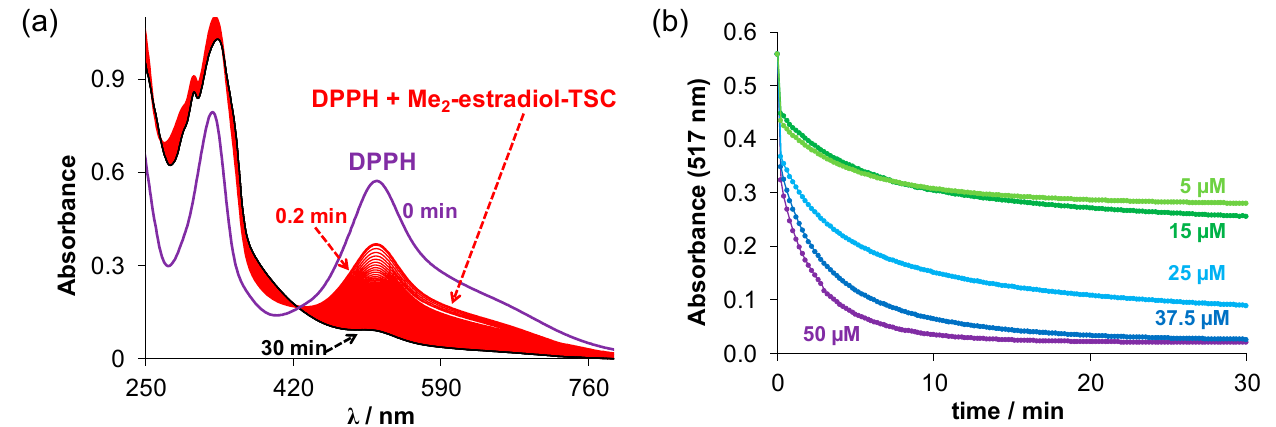
Figure 8. ( a ) Time-dependent changes of the UV–vis spectra of the DPPH • ( c = 50 µ M) in the presence of Me 2 -estradiol-TSC (50 µ M) in ethanol. ( T = 25 ◦ C); ( b ) absorbance changes of DPPH at 517 nm upon reaction with Me 2 -estradiol-TSC at different concentrations in ethanol plotted against time. ( c DPPH = 50 μ M; c ligand = 50, 37.5; 25; 15; 5 μ M; ℓ = 1 cm ; T = 25 °C). Table 5. DPPH free radical scavenging activity of estradiol-(T)SC, estrone-TSC, STSC, estradiol and Trolox expressed as IC 50 and Trolox equivalent antioxidant capacity (TEAC) values, and % scavenging effect